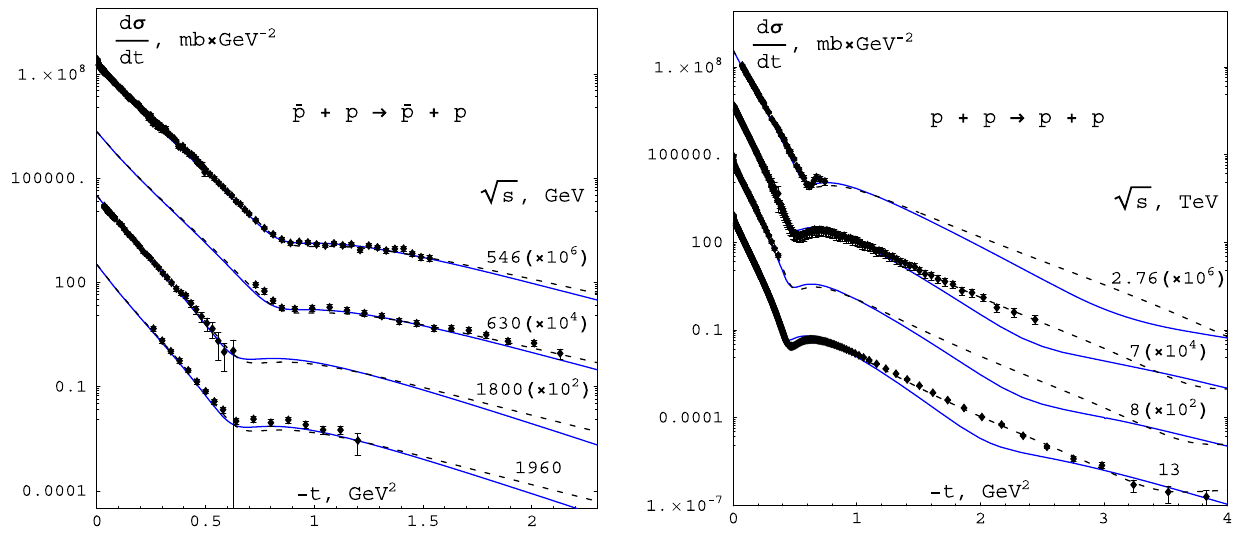
Fig. 4 The differential cross-sections of nucleon–nucleon EDS at ultrahigh energies. The solid lines correspond to the two-Reggeon eikonal model. The dashed lines are related to the three-Reggeon approximation wherein the HP exchange contribution is taken into account